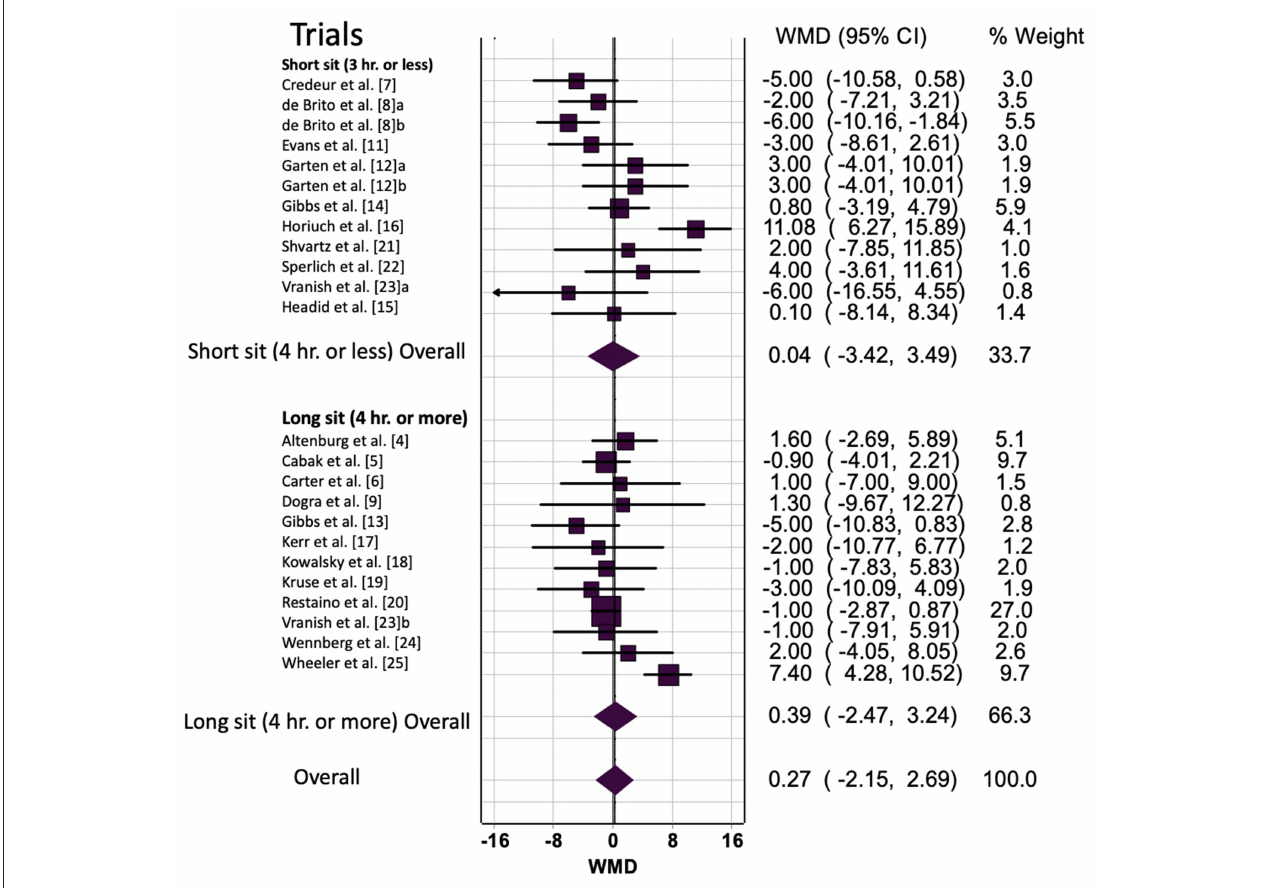
FIGURE 2 | Prolonged sitting bout duration (short vs. long) effect on heart rate. a/b, multiple trials within the same study; hr, hours; WMD, weighted mean difference; BPM, beats per minute; CI, confidence